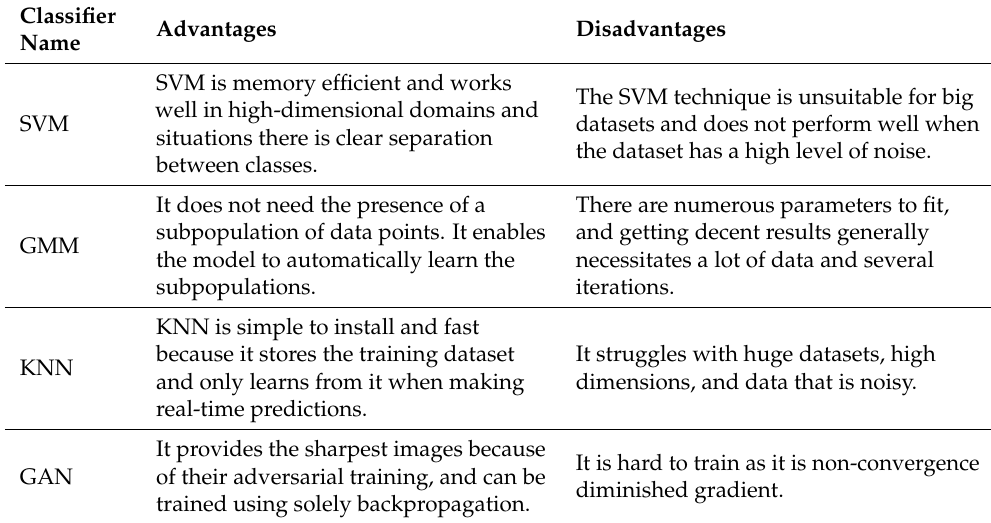
Table 21. Advantages and disadvantages of classification